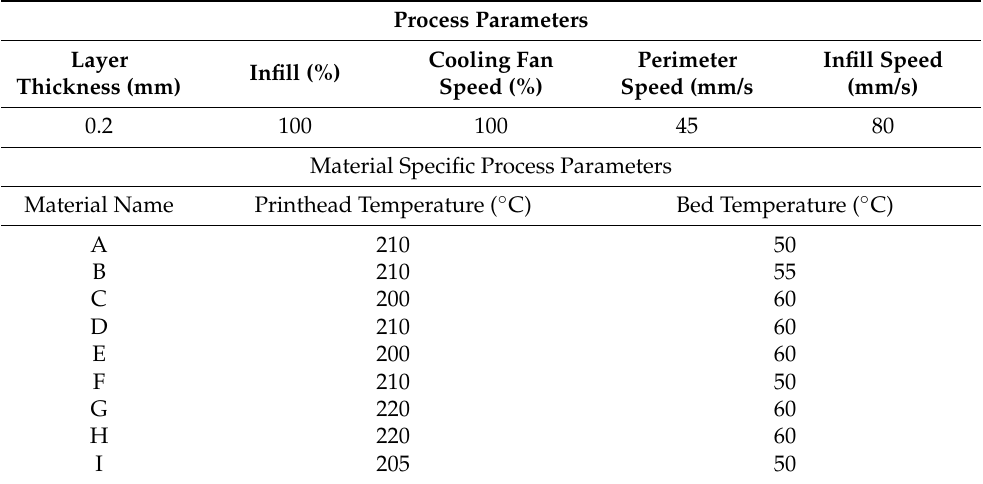
Table 2. Non-variable manufacturing process parameters and material specific